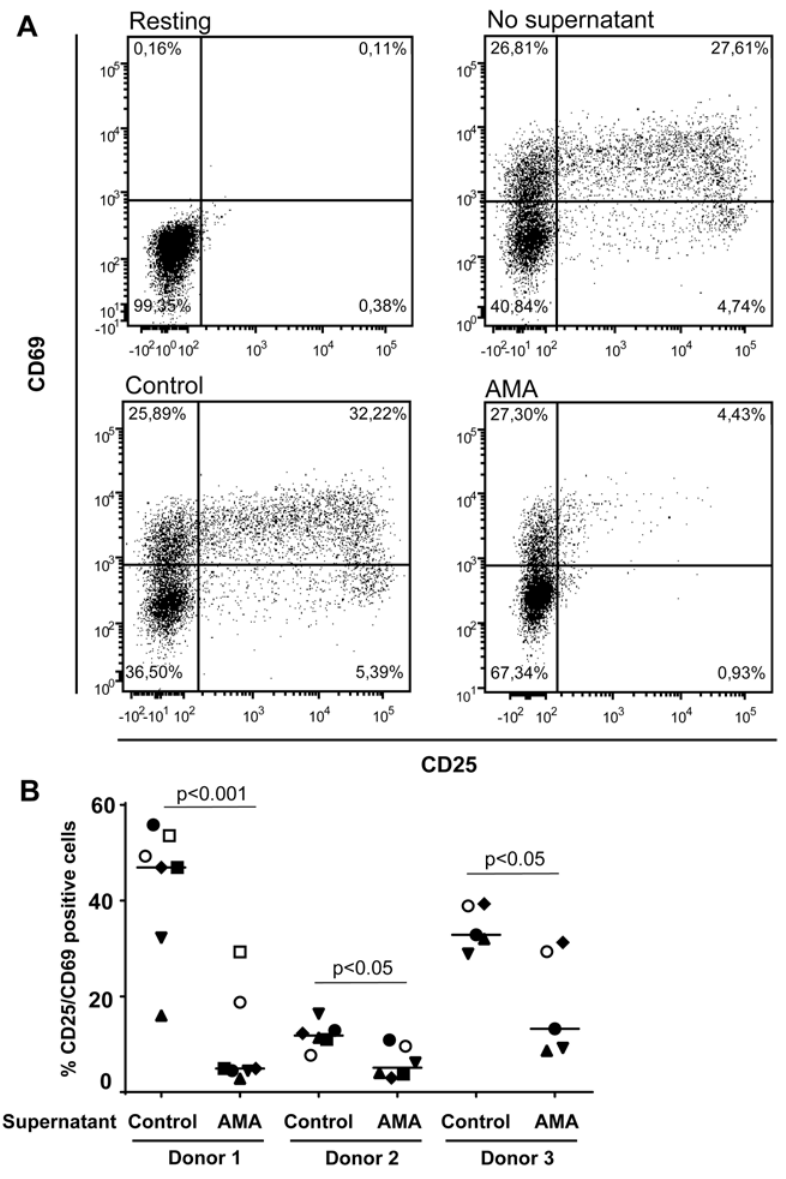
Fig 6. Conditioned medium from human B cells incubated with L . infantum amastigotes modulate CD4+ T-cell activation. Purified human CD25 - CD4 + T cells were either left untreated (resting) or activated with plate-bound anti-CD3 and anti-CD28 antibodies. For activated cells, samples were either left untreated (no supernatant), incubated with cell-free supernatants from untreated B cells (control), or incubated with cell- free supernatants from B cells exposed to L . infantum amastigotes at a final parasite:host cell ratio of 3:1 (AMA). Seventy-two hours later, cells were analysed for cell surface expression of CD25 and CD69 by flow cytometry. Dead cells were excluded by 7-AAD staining. A) A representative dot plot is shown for each tested condition. B) Percentages of CD25 + CD69 + Tcells for studies performed with CD25 - CD4 + T cells from 3 different donors incubated with cell-free supernatants from 5 to 7 different B-cell donors. Statistical significance was evaluated by two-tailed Student ’ s t-test.